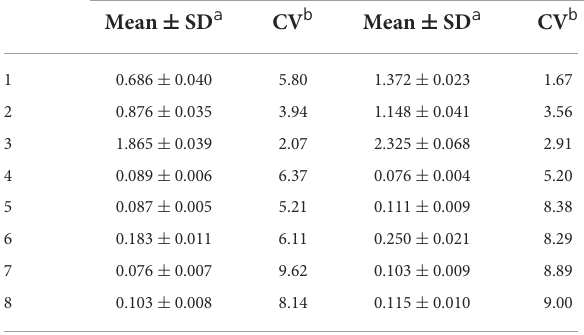
TABLE 3 CD2v-ex-iELISA